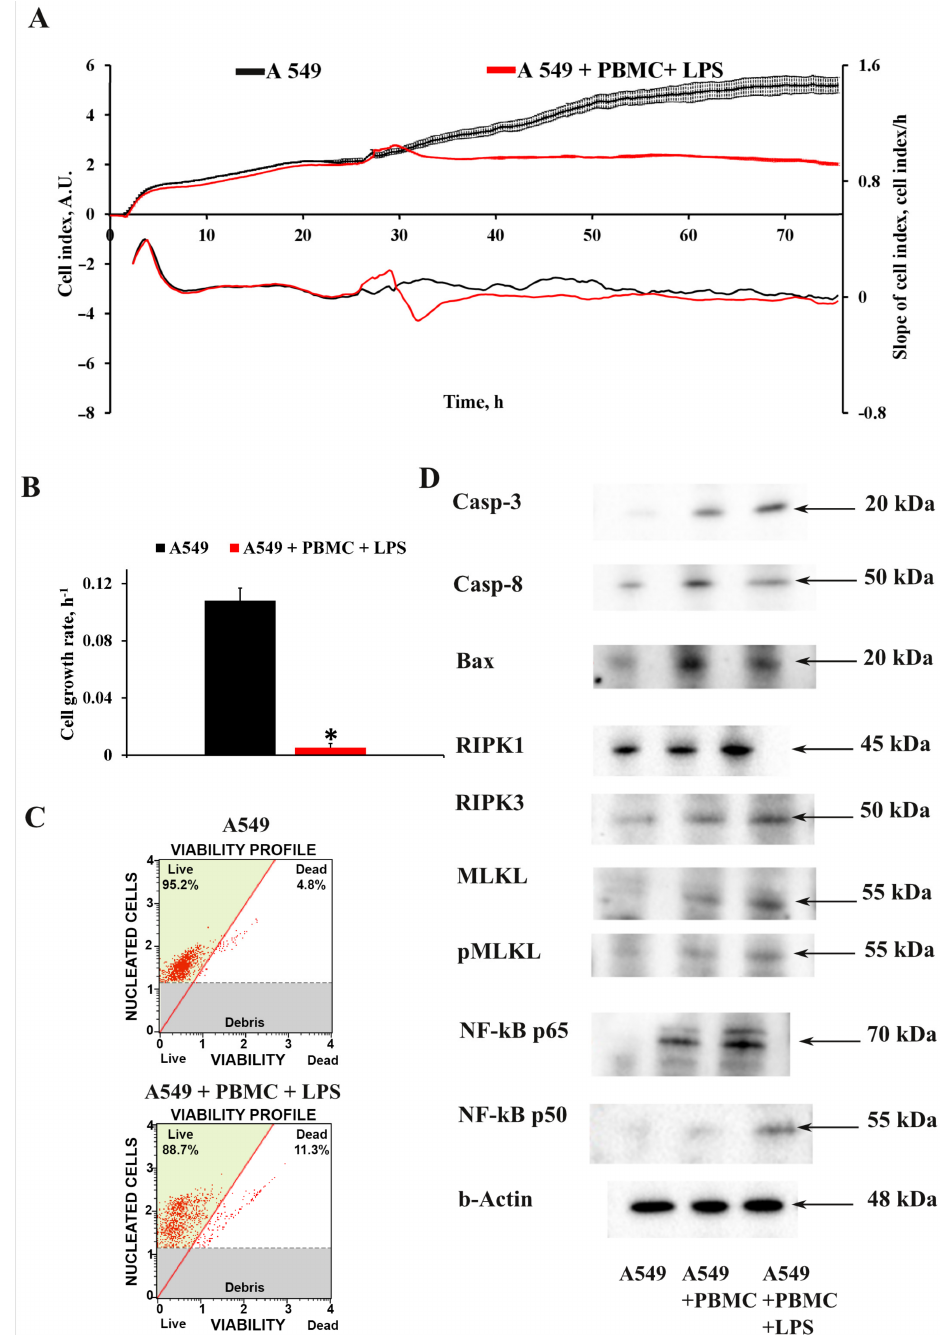
Figure 2. Assessment of A549 proliferation and cell death after 24-h impact of activated PBMC. ( A ) Real-time curve of cell index for A549 and ( B ) the cell growth rate measured with the RTCA iCELLi- gence over 55–70 h. A549 cells were seeded on the special detection plate and independence electron flow was detected and recalculated in cell index. ( C ) A549 death in the model conditions using Muse ® Count & Viability kit. A549 cells were collected 24 h after cocultivation with activated PBMC, and the viable cells were detected using the MUSE Cell Analyzer (Merck Millipore, Burlington, MA, USA). ( D ) Representative immunoblots for markers of PANoptosis cell death in A549. Actin staining was used as a loading control. Number of individual cultures for experiments was 3. Results are indicated as mean ± SEM; * p < 0.05, an unpaired Welch-corrected t -test was